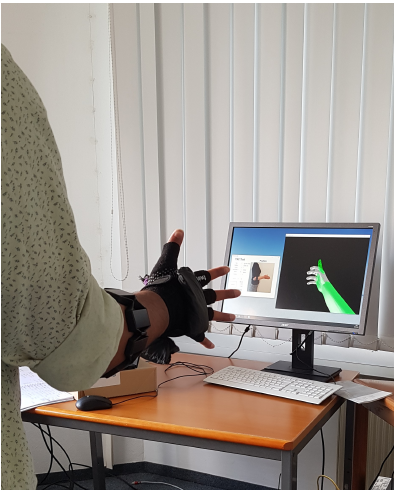
Figure 8. An example of a subject performing the TAC